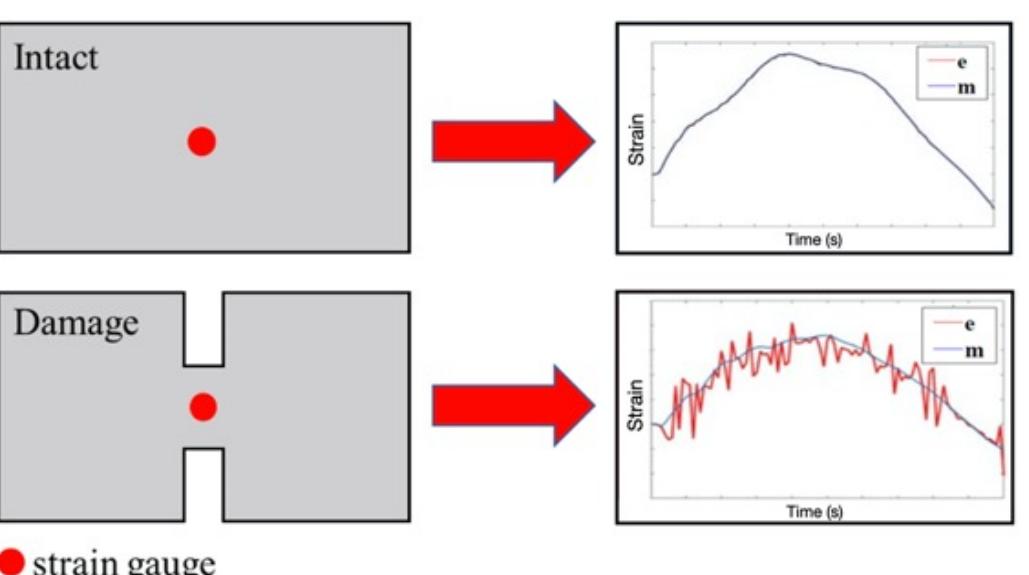
Figure 1. Schematic of the damage identification approach; “ e ” and “ m ” denote expanded and measured strains, respectively.